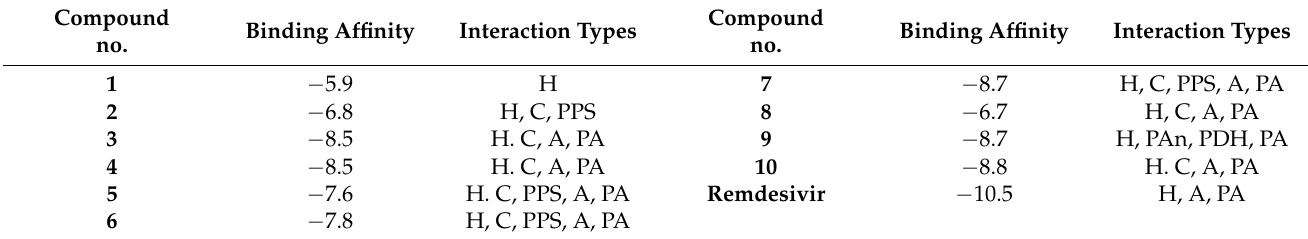
Table 4. Binding energy of the MGP analogs against M pro